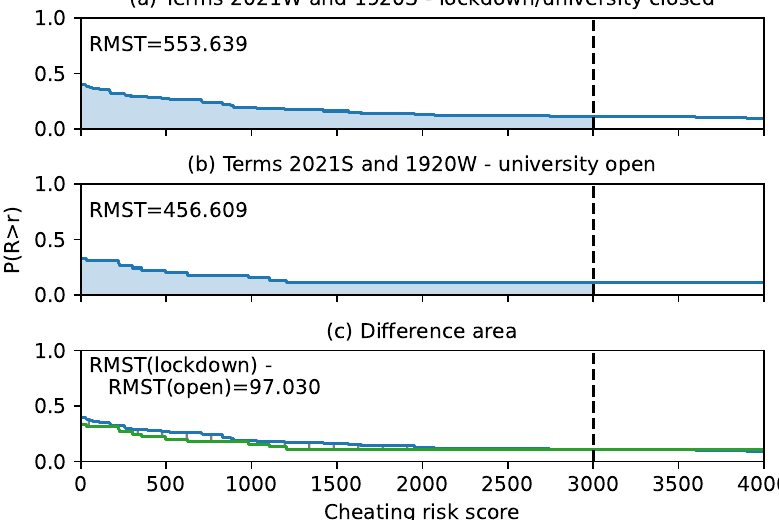
Figure 16. Comparison of student cheating risk score between four academic terms, two affected and two unaffected by the lockdown due to COVID-19 pandemic. W—winter term; S—summer